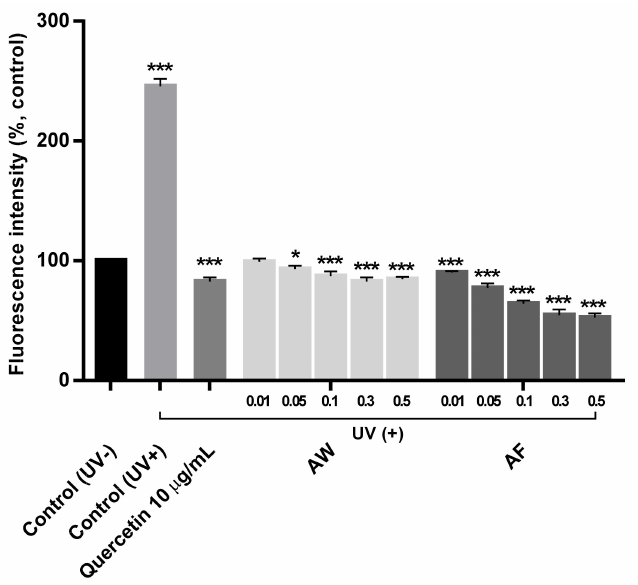
Figure 5. ROS production in UV b -irradiated human skin fibroblasts treated with 10 µ g/mL quercetin and various concentrations of the two aloe extract samples. AW: hot water extraction of Aloe vera leaf skin at 100 ◦ C for 24 h. AF: L. plantarum fermentation of Aloe vera leaf skin at 37 ◦ C for 3 days and extraction with an ultrasonicator at 40 kHz for 1 h at room temperature. The mean values ± SD for separate triplicate experiments are shown, and error bars indicate the SD. The significance of the difference was set to * p < 0.05 and *** p < 0.001 compared with the control (UV − )